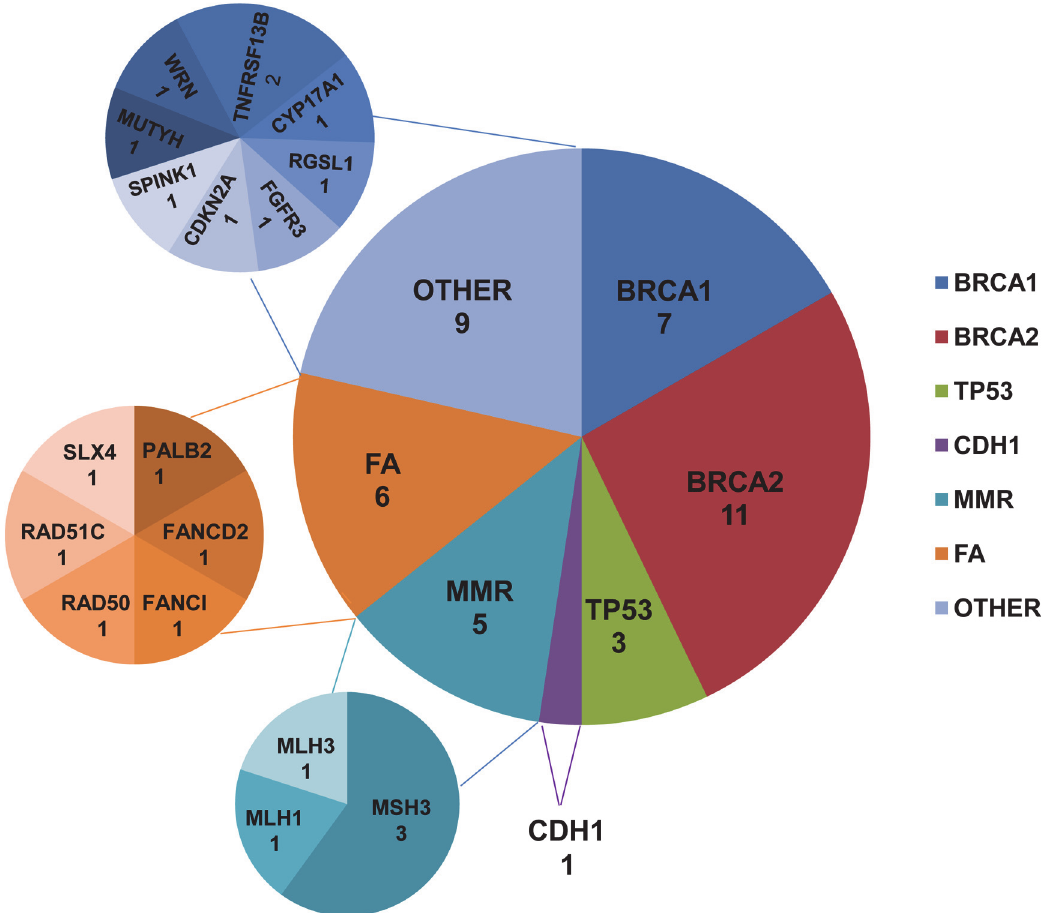
Fig 3. Number of germline loss-of-function mutations identified in different genes. Abbreviations: MMR, mismatch repair; FA, Fanconi anemia.